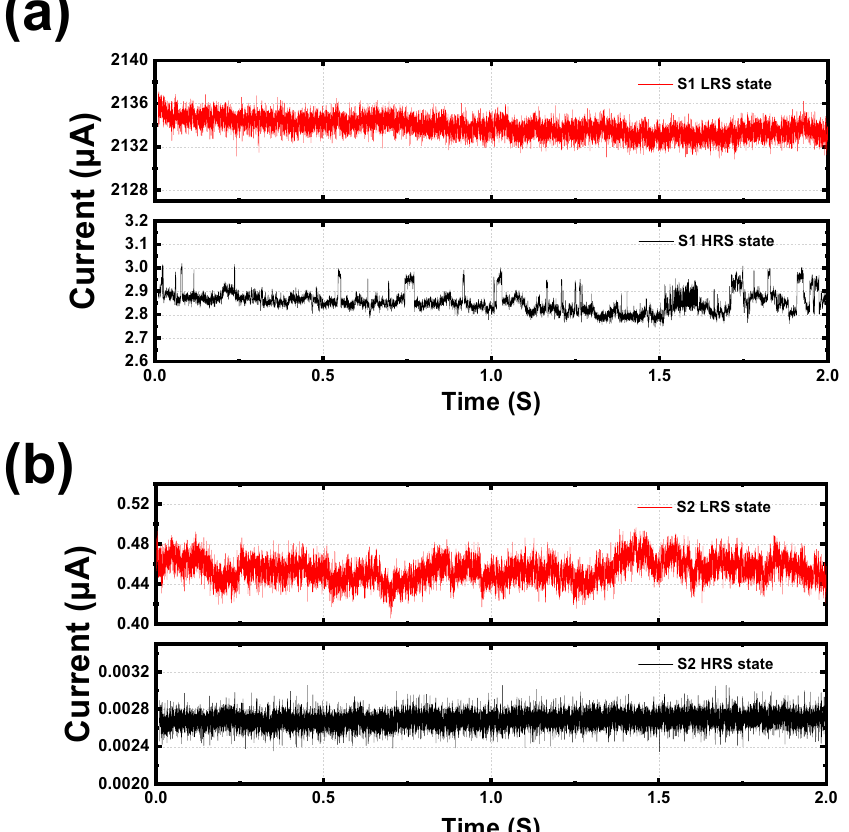
Figure 7. I - t characteristics of ( a ) S1 and ( b ) S2 under 0.1 V for both HRS and LRS.